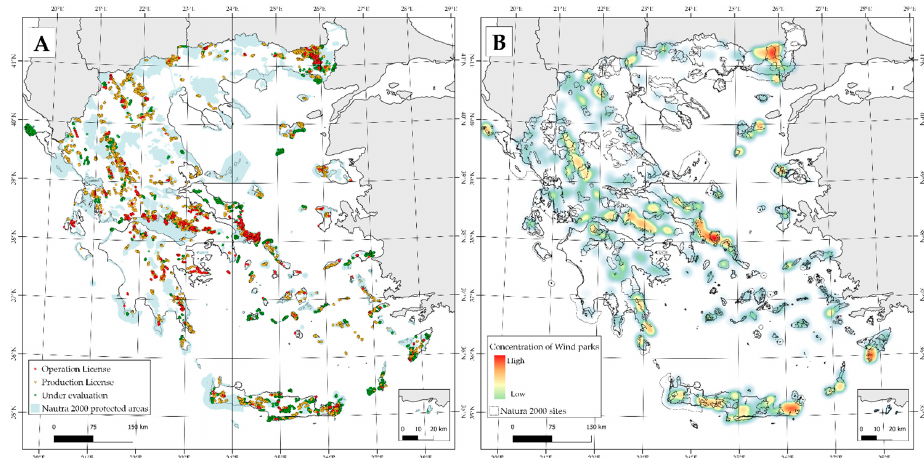
Figure 5. Concentration of wind farms showing the position of constructed wind turbines (with operation and production license) and proposed wind turbines under government evaluation; 16,896 proposed industrial wind turbines are mapped ( A ). The heat map produced by the concentration intensity of wind farms uses a 15 km radius (around each mapped turbine) to define levels of relative wind turbine concentration ( B ). Source: State-wide review from RAE [70], accessed: 29 May 2020. Land 2021 , 10 , x FOR PEER REVIEW